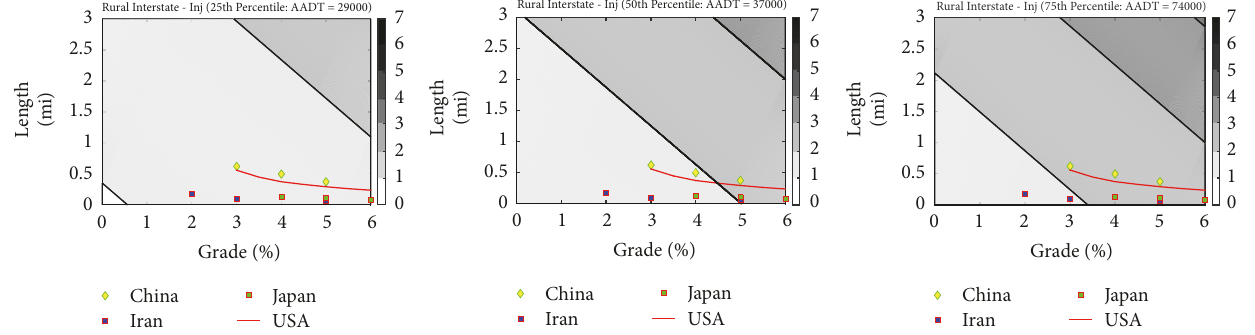
Figure 7: Prediction of rural interstate injury crash